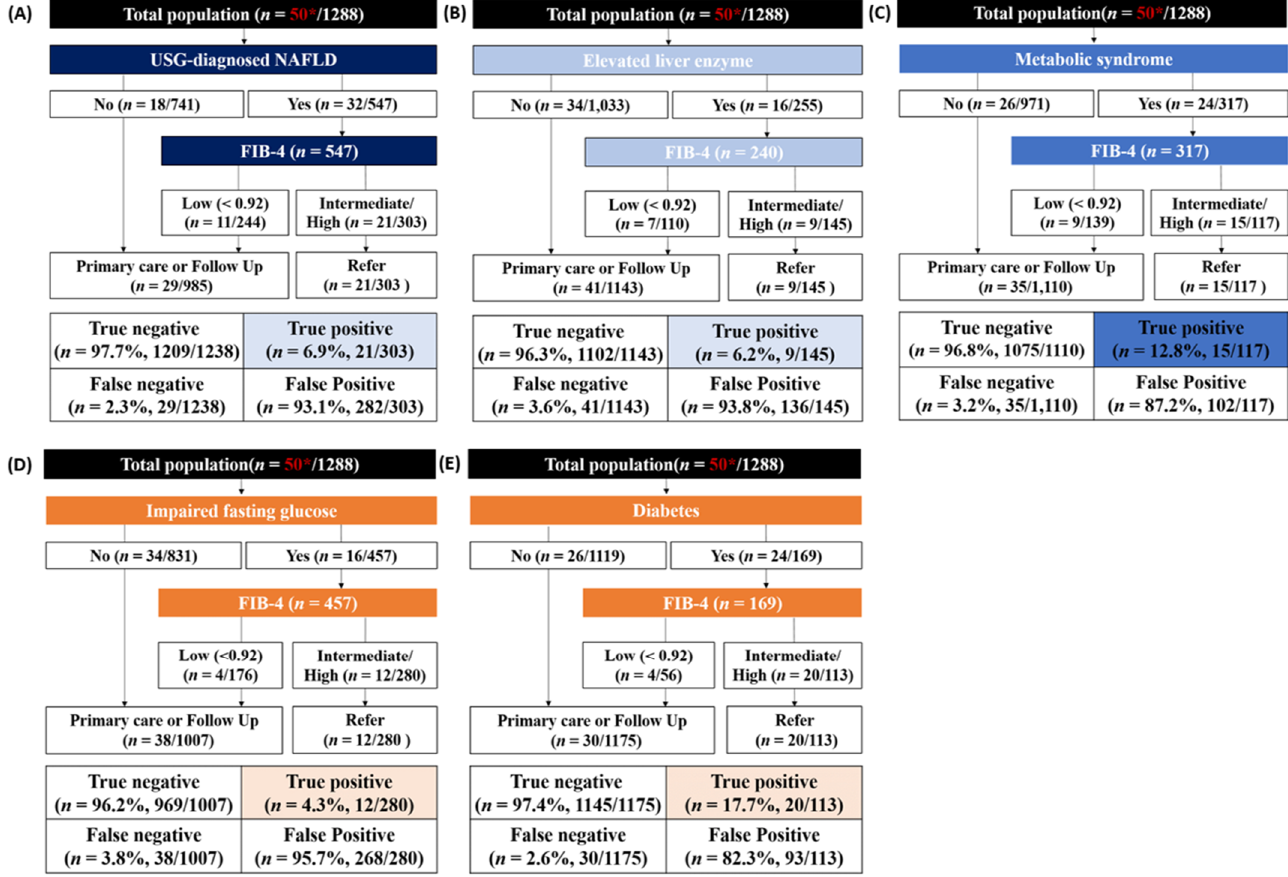
Figure 2. Test outcomes and referral rates of FIB-4 index-based screening in five conditions. ( A ) USG-diagnosed NAFLD; ( B ) Elevated liver enzyme; ( C ) Metabolic syndrome; ( D ) Impaired fasting glucose; ( E ) Diabetes. * The number of patients with significant fibrosis with 3.0 kPa or higher based on MRE criteria.